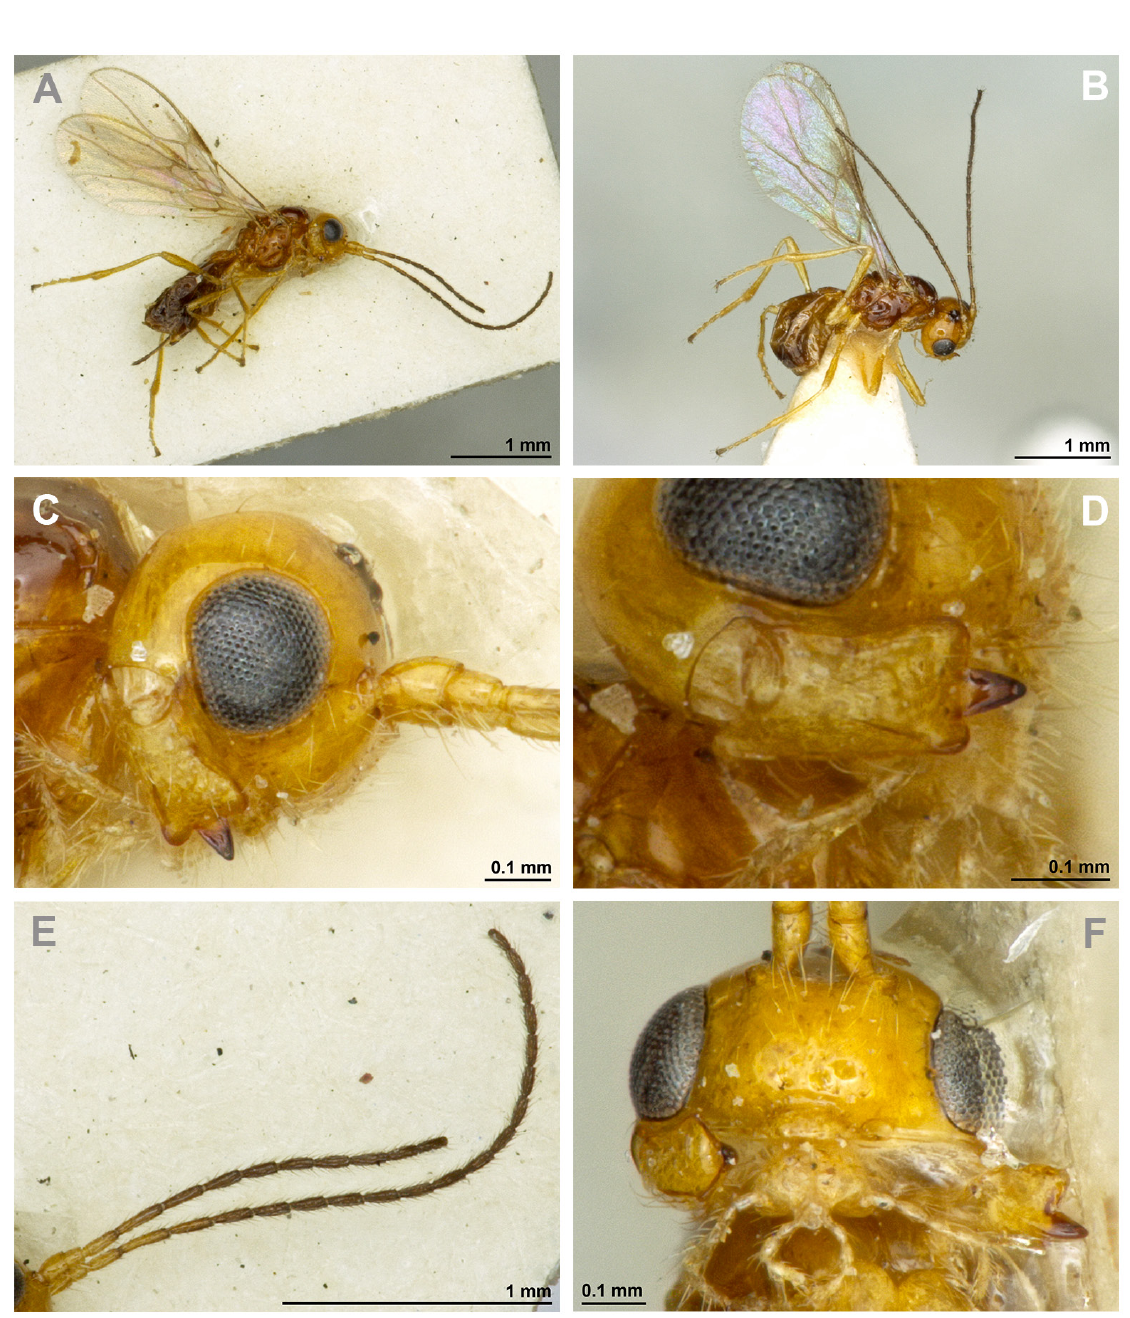
Fig. 54. Asobara sarae Peris-Felipo, sp. nov., A, C–F: ♀, holotype (BMNH 1922-25); B: ♂ (BMNH 1930-266). A–B . Habitus, lateral view. C . Head, lateral view. D . Mandible. E . Antenna. F . Head, front